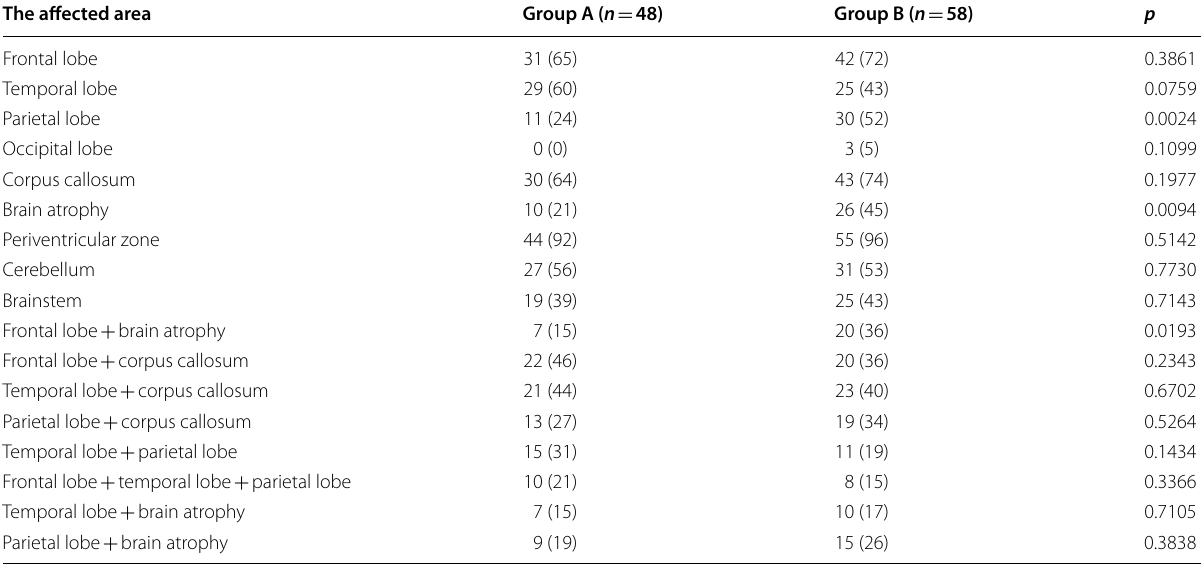
Table 2 Distribution of affected brain areas in both groups ( n , %) The affected